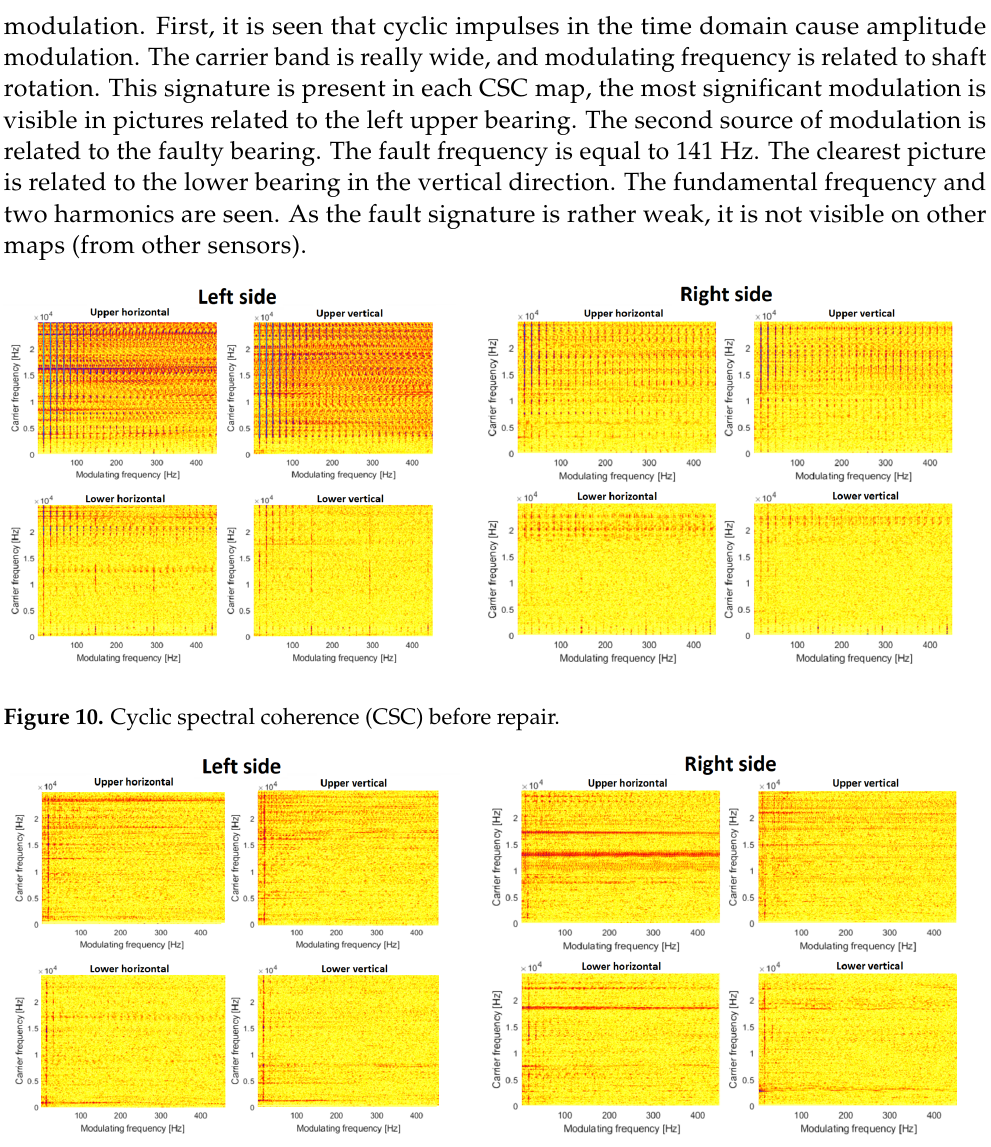
Figure 11. Cyclic spectral coherence (CSC) after